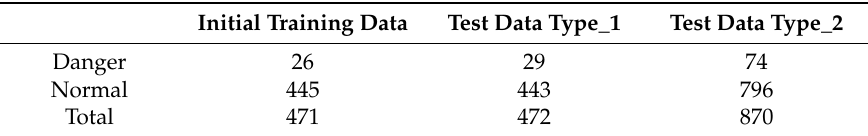
Table 4. Experimental dataset.